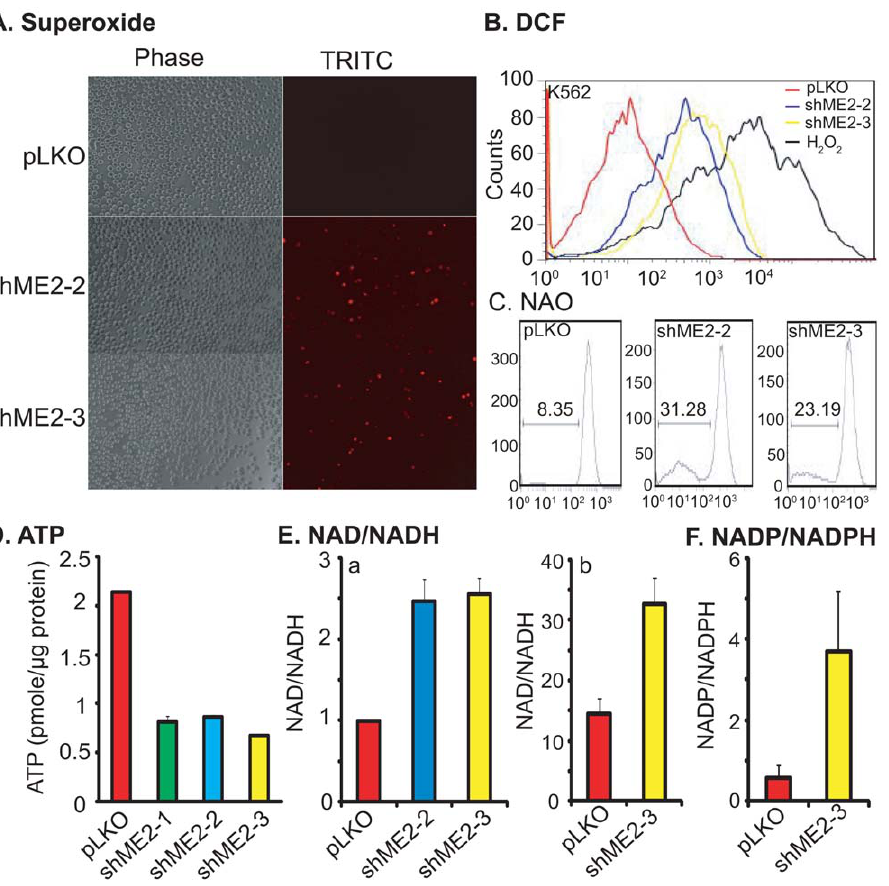
Figure 4. Depletion of endogenous ME2 enhances ROS generation, increases NAD + /NADH and NADP/NADPH ratios and decreases ATP levels. A: Accumulation of mitochondrially generated superoxide in K562 ME2 knockdown cells as detected by MitoSOX. Data are representative of two independent experiments. B: Increased ROS in K562 ME2 knockdown cells detected by flow cytometry using CM-H 2 DCF-DA. Each histogram is representative of three experiments. C. Comparison of oxidative damage to cardiolipin in ME2 knockdown versus control K562 cells. M1 indicates subpopulation of cells that lost NAO signal due to cardiolipin oxidation. D. Depletion of ME2 inhibits ATP production in K562 cells. Data are expressed as mean 6 SD, n=3. E: Depletion of ME2 increases NAD + /NADH ratio. a, NAD + and NADH were measured by NAD/NADH Assay Kit (Abcam, San Francisco, CA) as described in ‘‘Materials and Methods’’. Data are expressed as mean 6 SD, n=3. b, NAD + and NADH were measured by LC-MS methods as described in ‘‘Materials and Methods’’. F. Depletion of ME2 increases NADP/NADPH ratio in ME2 knockdown cells. NADP and NADPH were measured by LC-MS methods as described in ‘‘Materials and Methods’’.